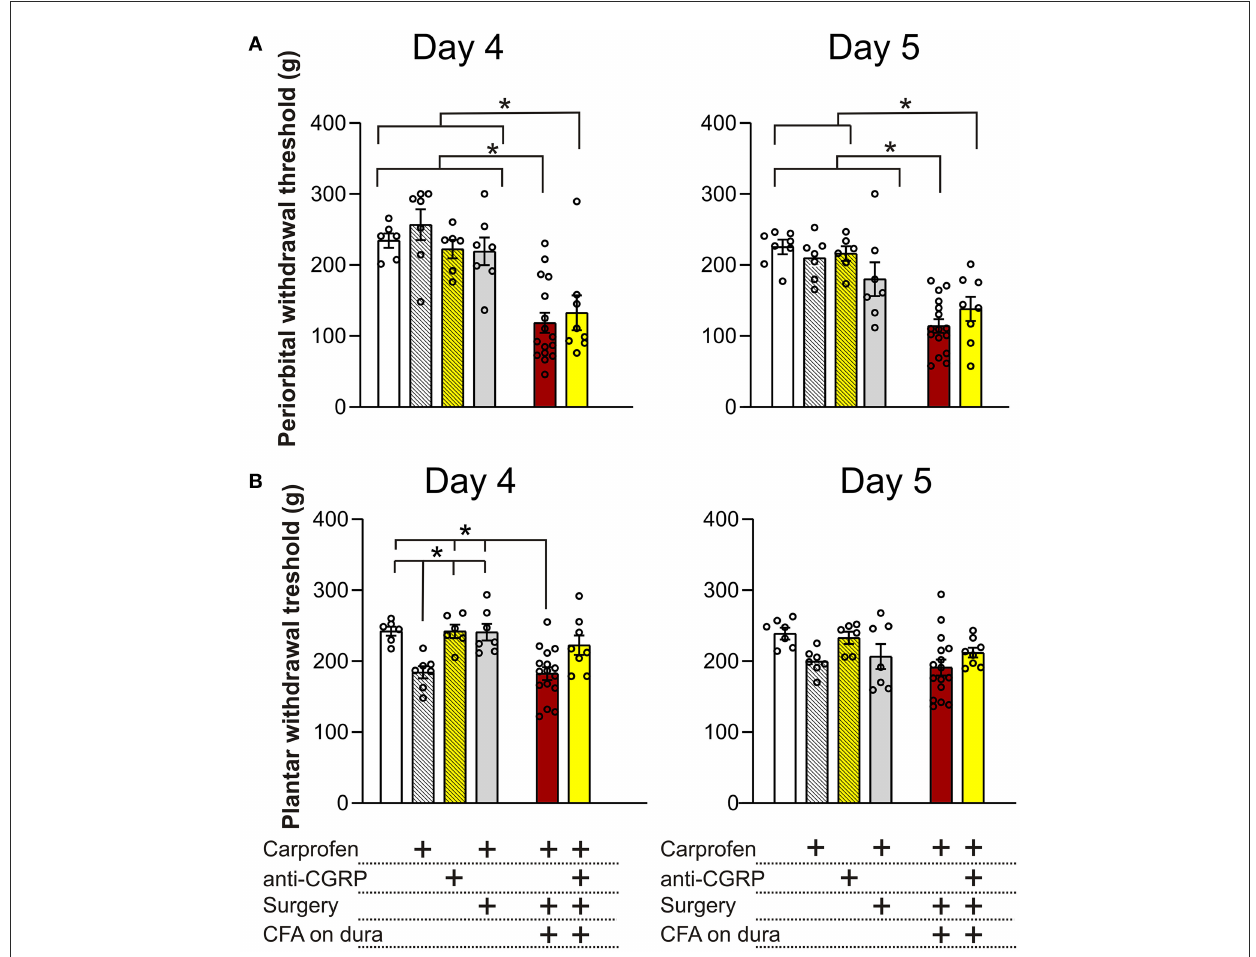
FIGURE5 Periorbital and plantar allodynia on day 4 and 5. (A) On day 4, no significant differences in periorbital withdrawal thresholds were observed between fresh + carprofen rats, fresh + anti-CGRP rats nor sham rats when compared with fresh rats. CFA rats had significantly lower periorbital withdrawal thresholds than fresh rats, fresh + carprofen rats and sham rats. No significant difference in periorbital withdrawal thresholds was observed between CFA + anti-CGRP and CFA rats, but CFA + anti-CGRP had significant lower periorbital withdrawal thresholds than fresh rats, fresh + carprofen rats, fresh + anti-CGRP rats and sham rats. On day 5, a similar tendency was observed. However, no significant difference in periorbital withdrawal threshold was observed between sham rats and CFA rats. (B) On day 4, fresh + carprofen rats had significantly lower plantar withdrawal thresholds than fresh rats. No significant differences were observed between fresh + anti-CGRP rats and sham rats, when compared with fresh rats. Sham rats had significantly higher plantar withdrawal thresholds than fresh + carprofen rats. CFA rats had significantly lower plantar withdrawal thresholds when compared with fresh rats. No significant difference was observed between CFA rats and fresh + carprofen rats. CFA rats had significantly lower plantar withdrawal thresholds than sham rats. None of the groups had significant differences than CFA + anti-CGRP rats. On day 5, no differences in plantar withdrawal thresholds were observed between groups. Data are shown with mean ± SEM, and p values (at least * p < 0.05 from the One-Way ANOVA and Tukey post-tests are depicted in the